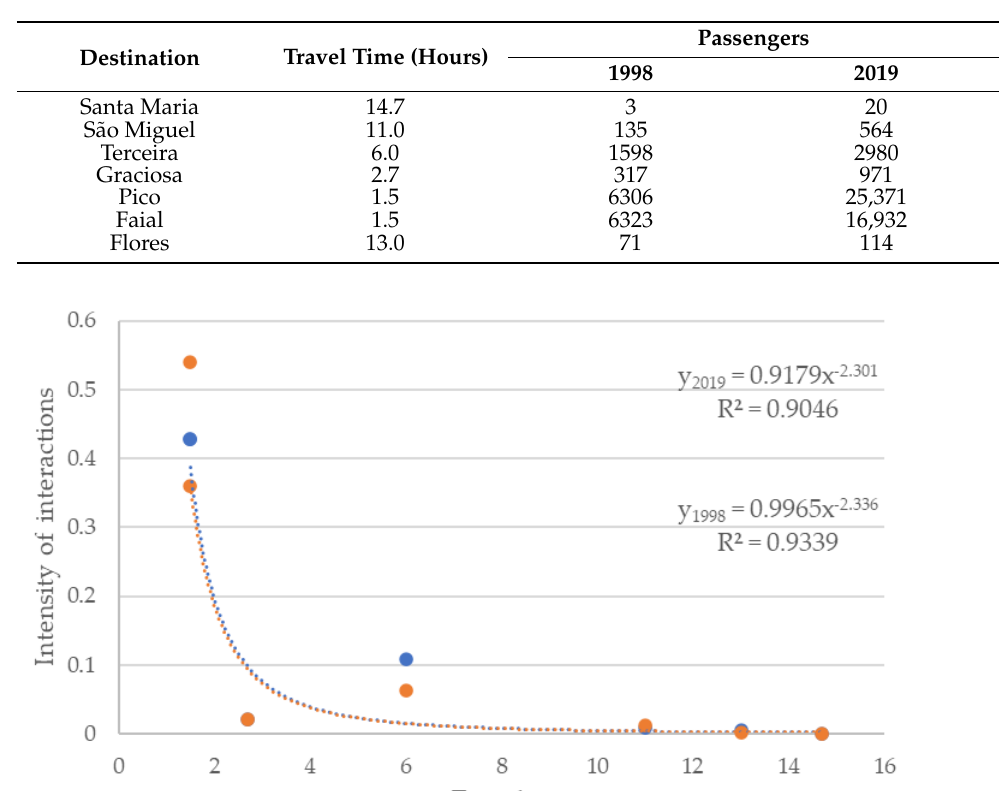
Table 3. Data for maritime connections to São Jorge Island from the rest of the archipelago — for 1998 and 2019.